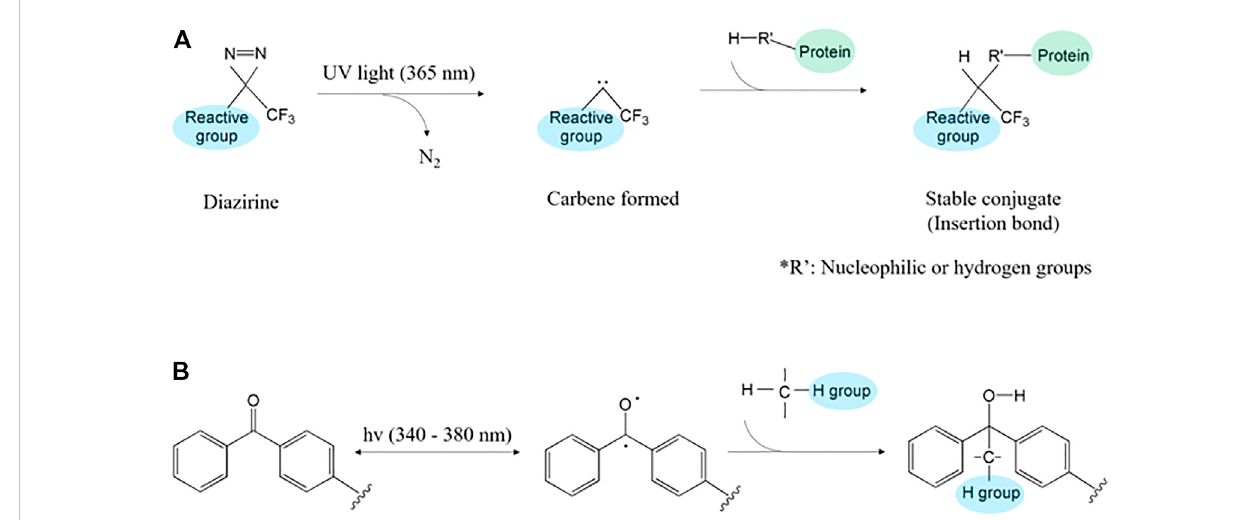
FIGURE 4 The protein polymerization mechanism through photocrosslinking of (A) diazirine and (B)